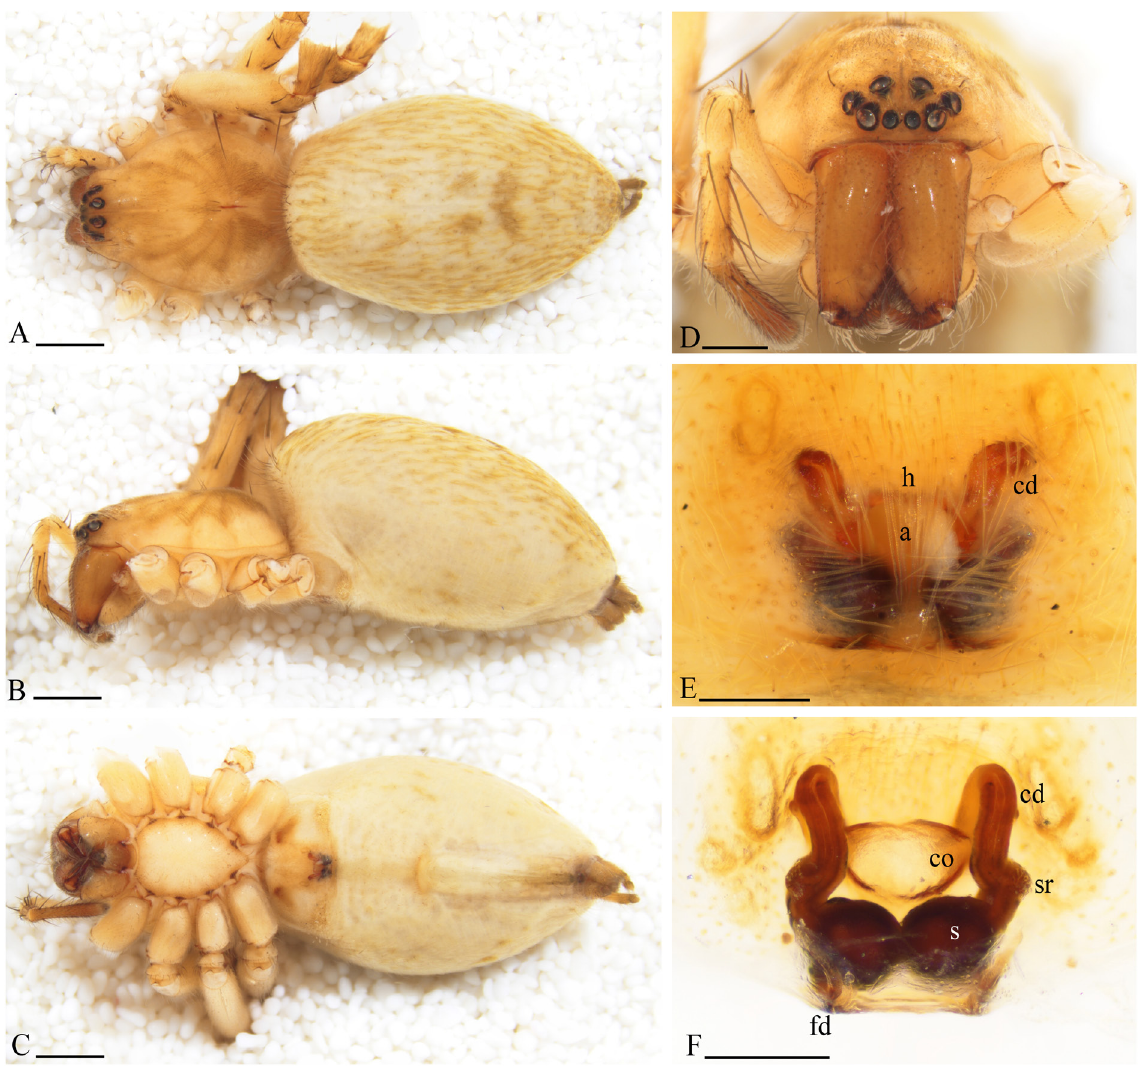
Fig. 36. Anyphaena sofiae sp. nov., paratypes, ♀♀ (CNAN-T01572, CNAN-T01573). A . Dorsal habitus. B . Lateral habitus. C . Ventral habitus. D . Prosoma, anterior view. E . Epigynum, ventral view. F . Epigynum, dorsal view. Scale bars: A–C = 1.0 mm; D = 0.5 mm; E–F = 0.2